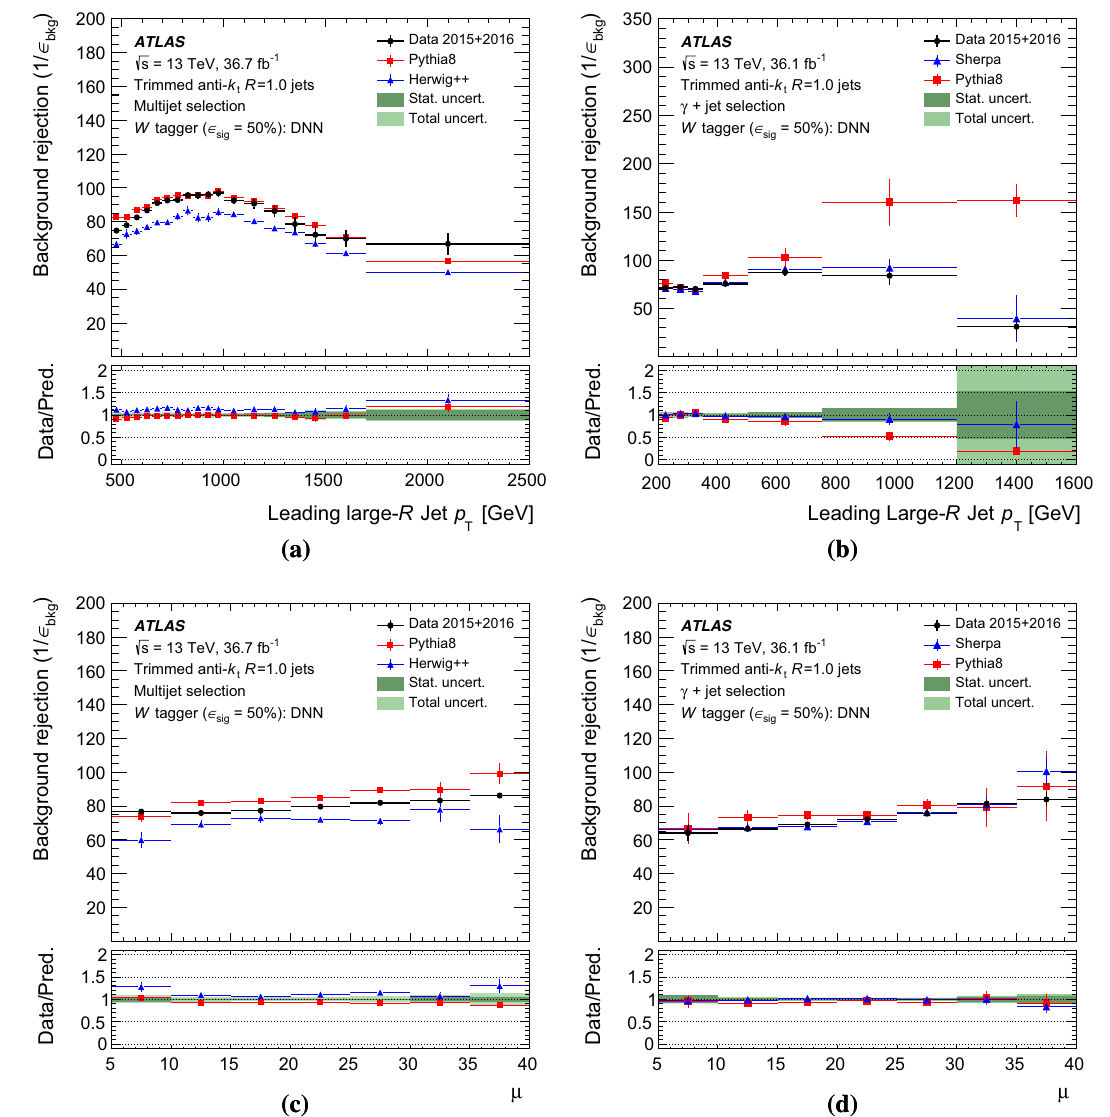
Fig. 34 The estimated light-jet rejection 1 /(cid:12) bkg as a function of the leading jet p T and the average number of interactions per bunch crossing μ for the DNN W -boson tagger in the multijet ( a , c ) and γ + jet ( b , d ) selection